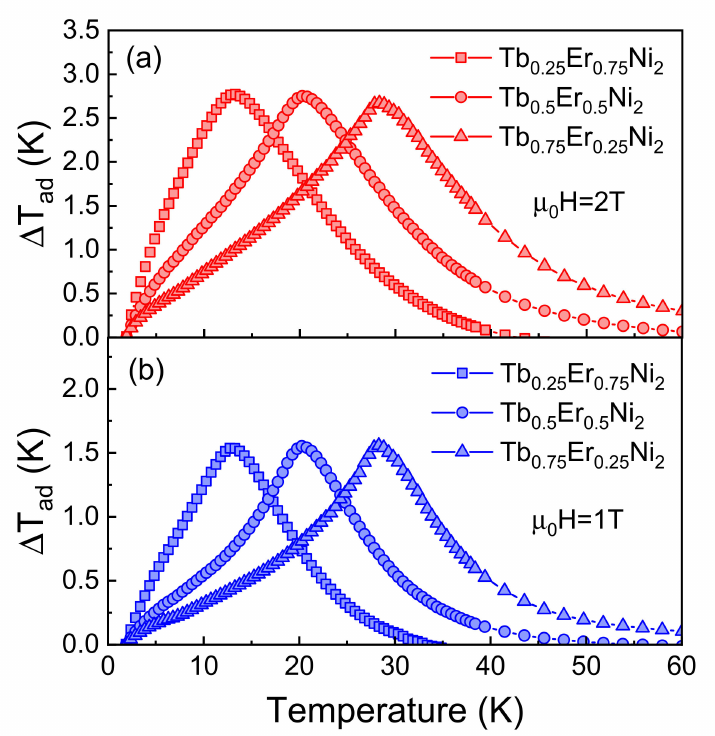
Figure 4. Adiabatic temperature change vs. temperature calculated from heat capacity data for the Tb 1-x Er x Ni 2 compounds (x = 0.25, 0.50 and 0.75) calculated for the magnetic field change: ( a ) µ 0 ∆ H = 2 T; and ( b ) µ 0 ∆ H = 1 T. Table 2. Magnetocaloric parameters for the parent TbNi 2 , ErNi 2 and compounds Tb 0.75 Er 0.25 Ni 2